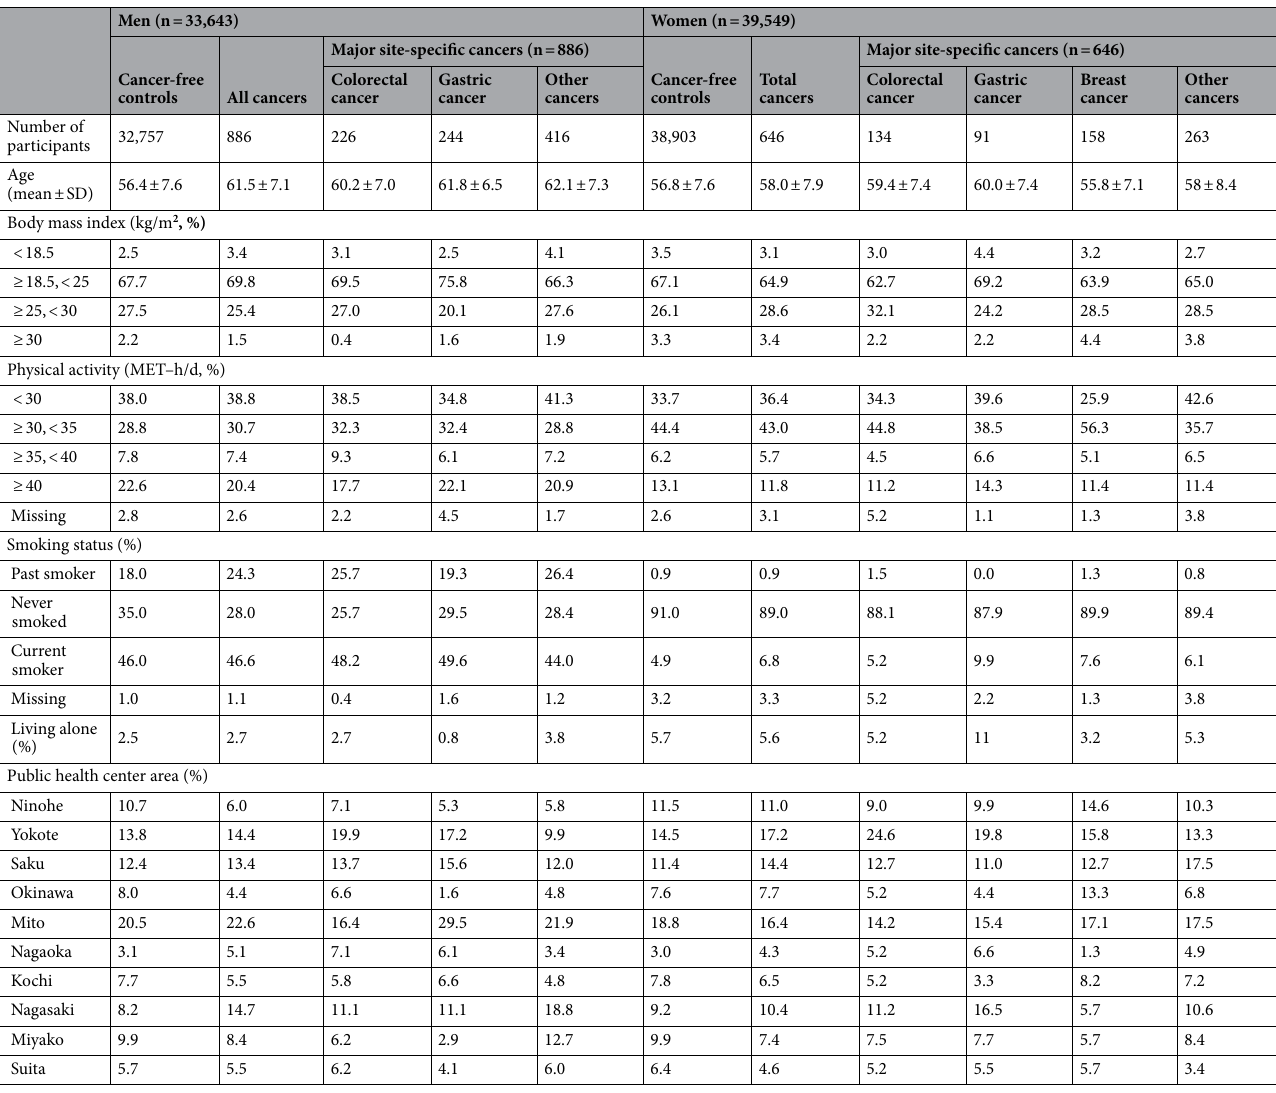
Table 1. Characteristics of participants according to cancer diagnosis and specific cancer site: the Japan Public Health Center-based Prospective Study, 1995 and 1998 (n = 73,192). MET– h Metabolic equivalent